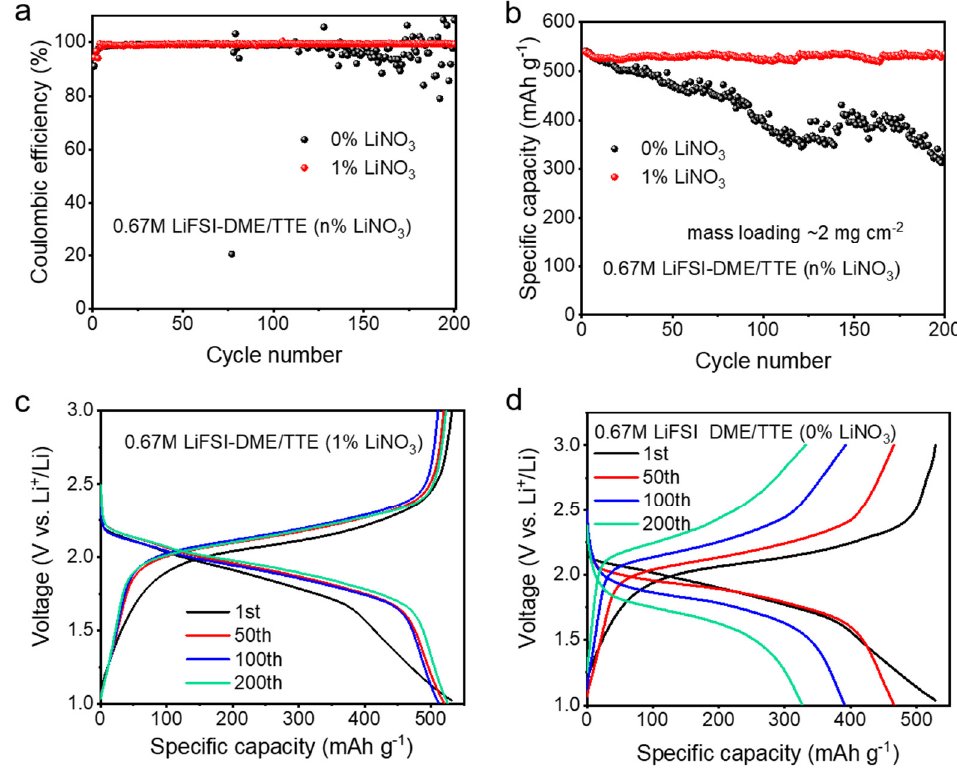
Figure 2. ( a ) CE testing of Li||Cu half–cells with diluted electrolytes of varying lithium nitrate content; ( b ) Cycling stability of Li||pPAN/SeS 2 half–cells with diluted electrolytes of different lithium nitrate contents. The galvanostatic current charge–discharge curves; ( c ) 0.67 M LiFSI in DME/TTE (1% LiNO 3 ); ( d ) 0.67 M LiFSI in DME/TTE (0% LiNO 3 ).